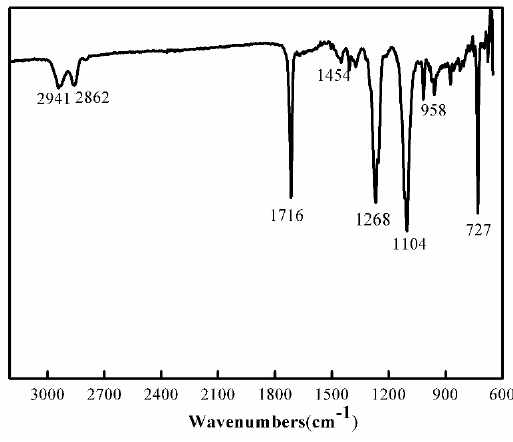
Figure 2. ATR-FTIR spectra of the sample PCT50.